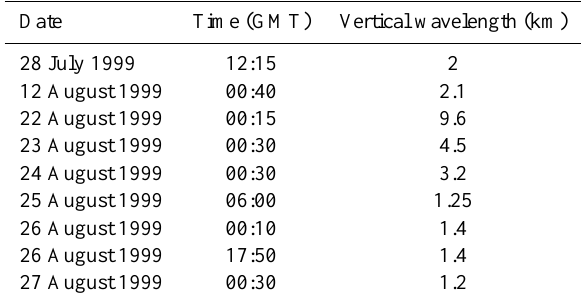
Table 3. Vertical wavelength of the wave activity in